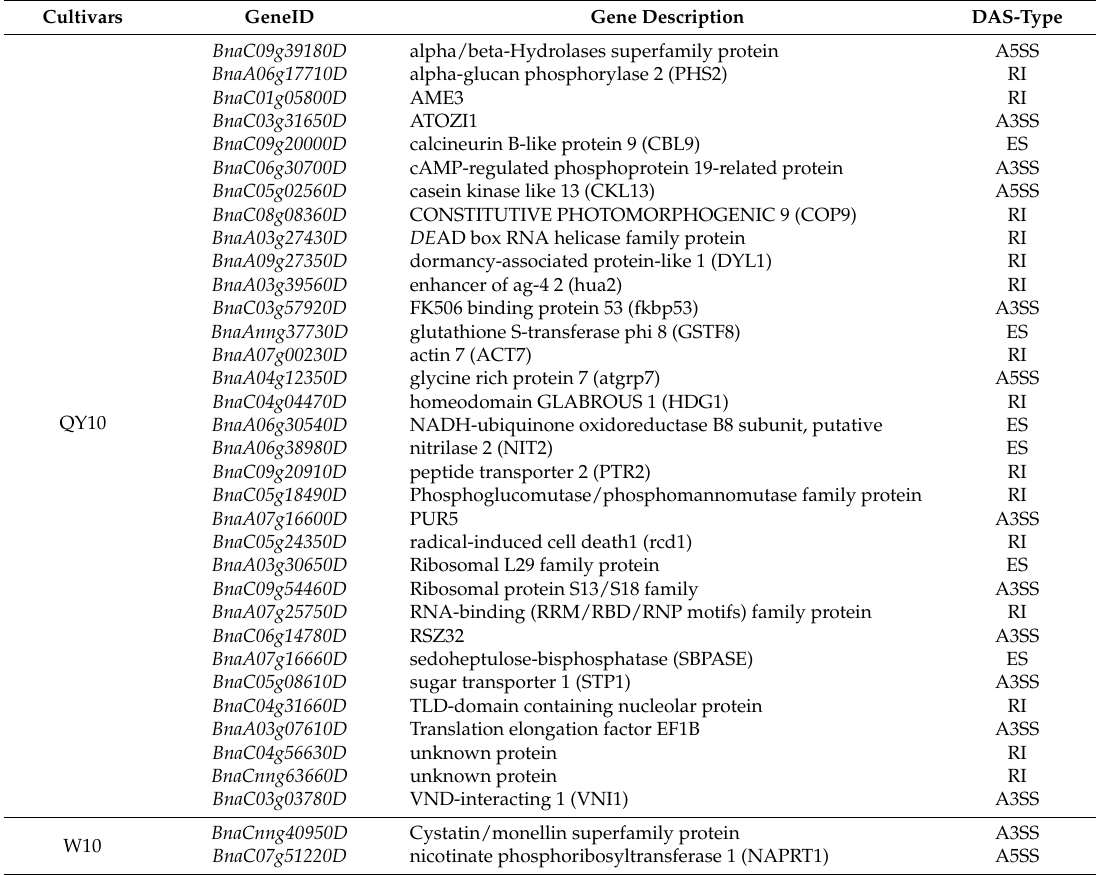
Table 3. Thirty-three and two differential alternative splicing genes detected in root, juvenile leaves and old leaves simultaneously in B. napus cultivars Qingyou10 and Westar10,